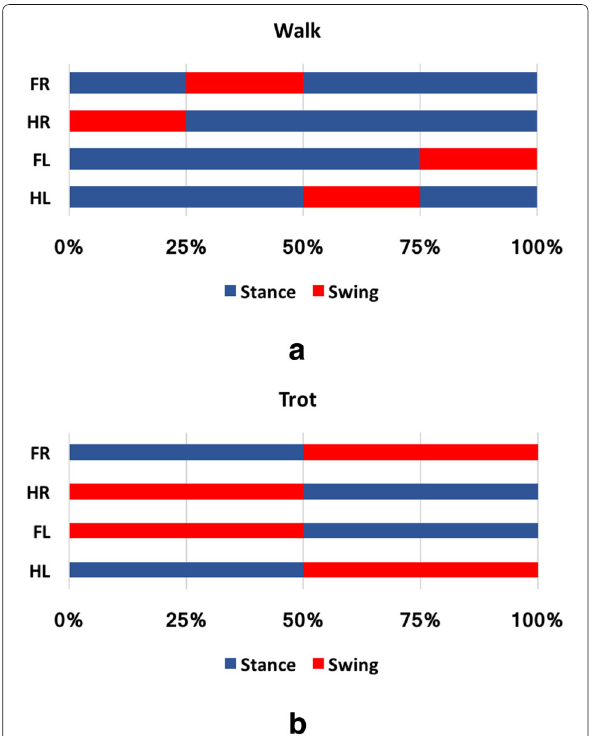
Fig. 4 Gait Diagram. Panel a shows the typical walk gait diagram for quadrupeds and panel b shows the ideal trot gait for quadrupeds, adopted from [53]. In each of the graphs, blue and red bars are the stride cycle part that leg is in the stance phase (foot on the ground) and the part that leg is in the swing phase, respectively. FR, HR, FL, and HL are front right, hind right, front left, and hind left,